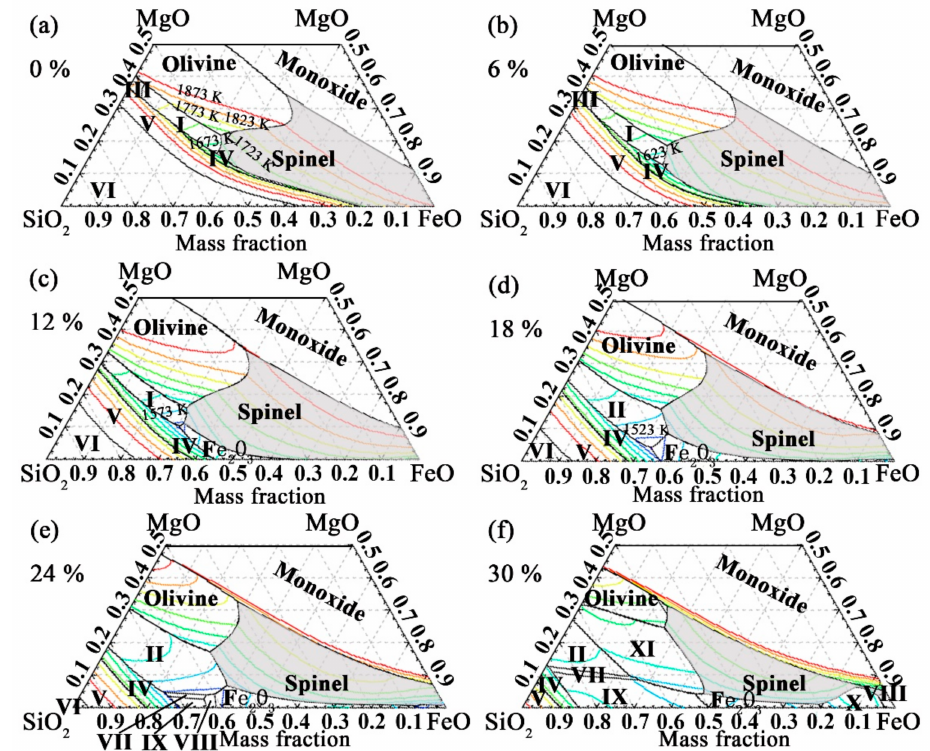
Figure 3. Effects of CaO addition on the phase diagram of FeO-SiO 2 -MgO-CaO slag in an air atmosphere. (I–XI represents orthopyroxene, clinopyroxene, protopyroxene, SiO 2 (s4), SiO 2 (s6), Liquid Slag, wollastonite, Ca 2 Fe 2 O 5 (s), CaSiO 3 (s2), Ca 2 SiO 4 , and melilite, respectively). ( a – f ): w (CaO) was specified as 0 wt.%, 6 wt.%, 12 wt.%, 24 wt.%, and 30 wt.%,